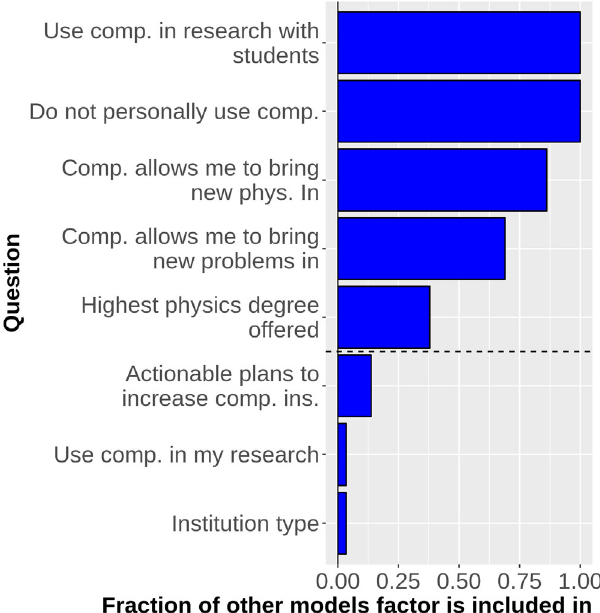
FIG. 7. Fraction of the other 29 models in which the variables are selected as meaningful. Variables above the line were selected as meaningful in the original